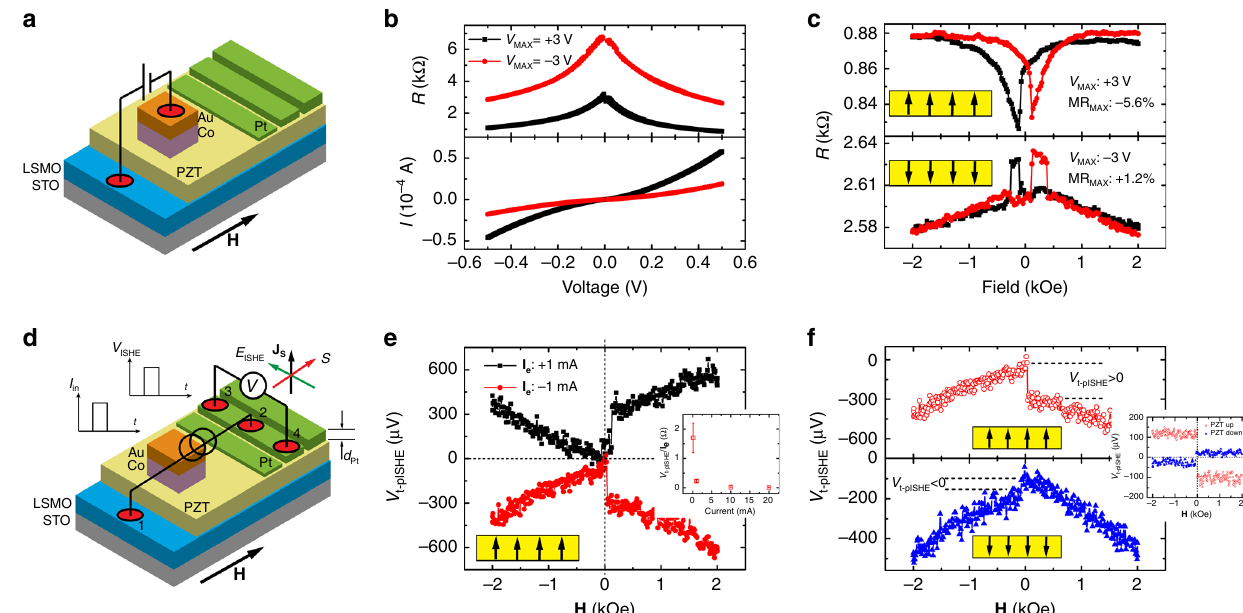
Fig. 2 Ferroelectric control of spin transport in MFTJ and ISHE devices. a Schematic structure of the LSMO/PZT/Co (MFTJ-type device). b I(V) and R (V) curves of the MFTJ-type device with the polarization of PZT switched by V MAX = + 3.0 V (black squares) and − 3.0 V (red circles), corresponding to PZT polarized up and down, respectively. c TMR loops of MFTJs measured at V MR = − 0.5 V for PZT polarized up (top panel) and down (bottom panel), showing a negative and positive TMR response, respectively. The inserted diagram in each panel stands for the ferroelectric states of the PZT layer. d Schematic illustrations of tunneling pulsed ISHE measurements in the ISHE-type device on the same substrate with the MFTJ-type device. The injected pulsed tunneling current ( I e ) generates a fl ow of pulsed spin current ( J S ) in the Pt metal, which produces a transverse pulsed ISHE voltage (V t-pISHE ). e typical measured V t-pISHE ( H ) plots at I e = ±1 mA in one ISHE-type device with as-grown PZT fi lm (5 nm thickness, polarization pointing up), respectively. The magnetic fi eld is swept from negative to positive fi eld. The inset shows the measured V t-pISHE / I e as a function of current. The error bars represent the standard deviation obtained from three different measurements. f The raw V t-pISHE ( H ) response ( I e = − 1 mA) at two polarization states of PZT layer. The inset fi gure shows the response after subtracting the symmetric AMR response. The reversed voltage jumps around H = 40 Oe indicates a reversed ISHE response in the Pt metal. All the measurements were taken at 10 K, and the current density is ~10 Acm − 2